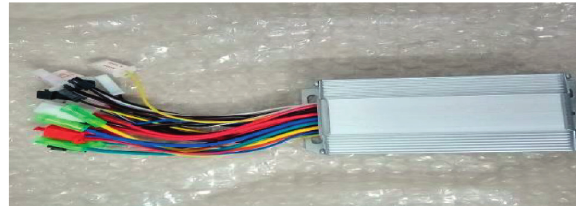
Figure 7: Typical model of the motor